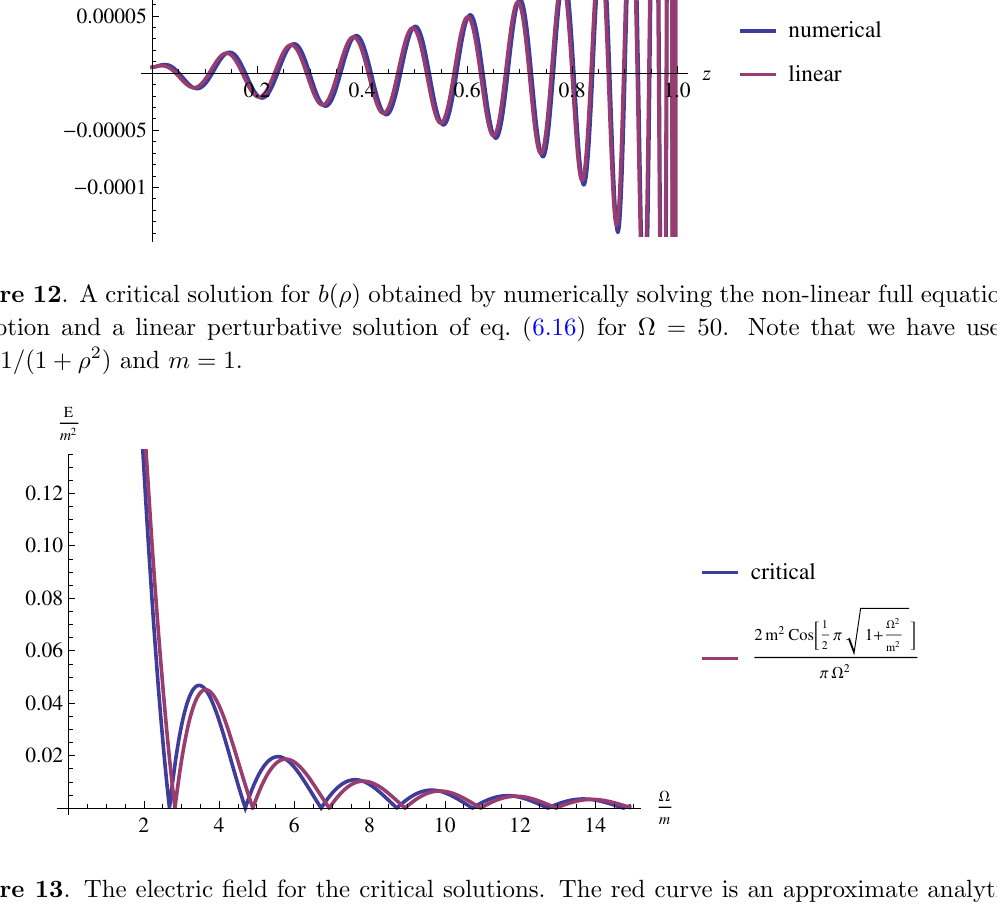
Figure 13 . The electric (cid:12)eld for the critical solutions. The red curve is an approximate analytic formula given by eq. (6.17), and the blue curve is the critical value obtained numerically, which is identical to the phase boundary shown in (cid:12)gure 3